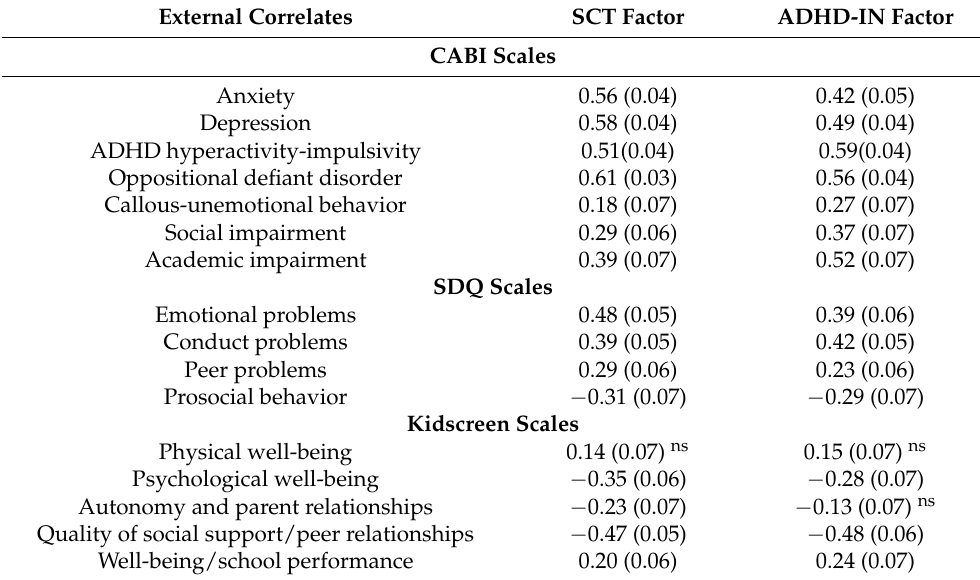
Table 2. Correlations (Standard Errors) of Sluggish Cognitive Tempo (SCT) and ADHD-Inattention (IN) Factors with CABI, SDQ, and Kidscreen Scales as Manifest